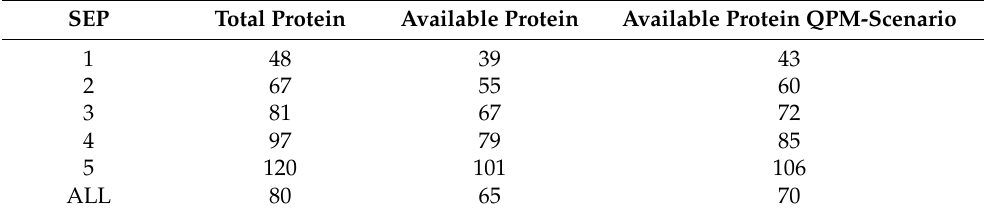
Table 2. The median total and available protein supplies (g AME − 1 day − 1 ) by household socioeco- nomic position, including under a scenario with universal adoption of quality protein maize (QPM). SEP